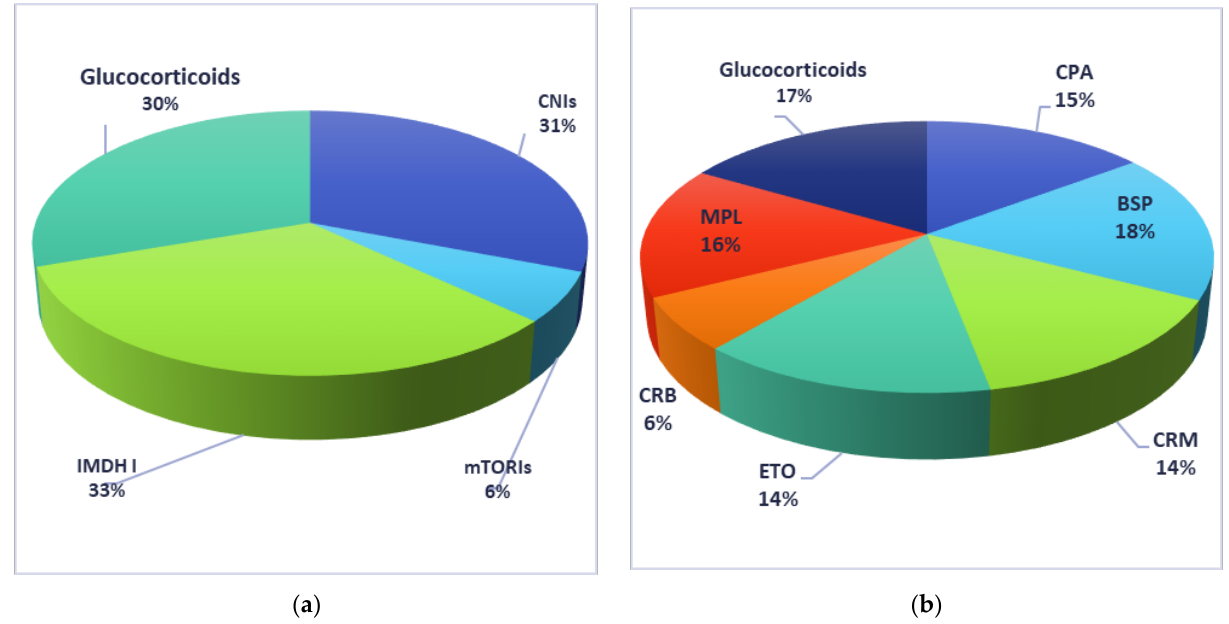
Figure 2. Immunosuppressive drugs used by recipients included in the current manuscript: ( a ) solid-organs recipients; ( b ) bone-marrow recipients. CNIs: calcineurin inhibitors; mTORIs: mTOR inhibitors; IMDH I: inhibitors for inosine monophosphate dehydrogenase; CPA: cyclophosphamide, BSP: busulphan; CRM: carmustine; ETO: etopside; CRB: cytarabine; MPL: melphalan. Table 4. Demographical and medical data of cardiac transplant recipients.